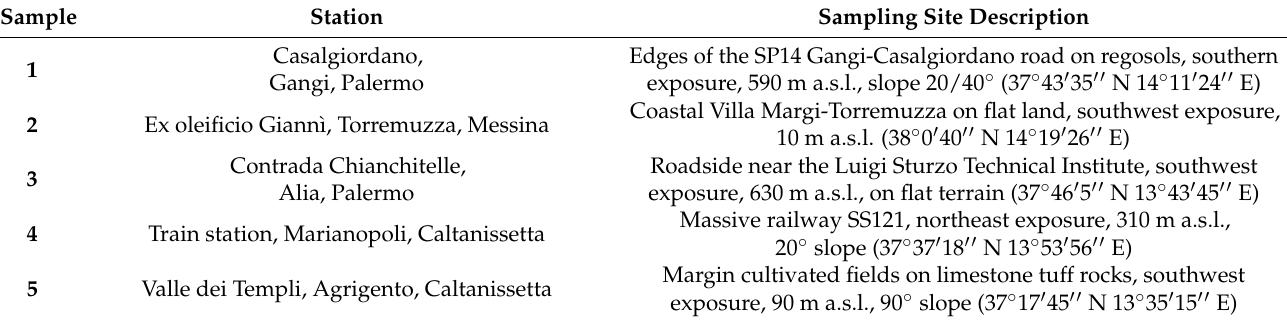
Table 1. C. spinosa sampling site